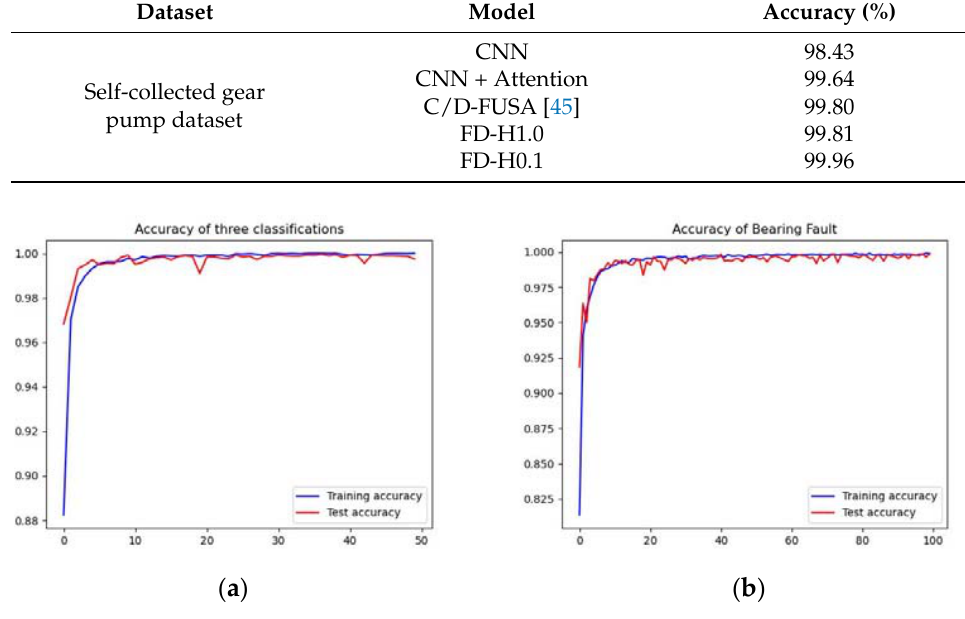
Figure 6. Accuracy curves of the proposed methods on different datasets, where ( a ) is the accuracy graph of the proposed method with h = 0.1 for fault detection on the self-collected gear pump dataset and ( b ) is the accuracy curves of the proposed method with h = 0.1 on the CWRUdataset. Table 5. Comparison of experimental results for rolling